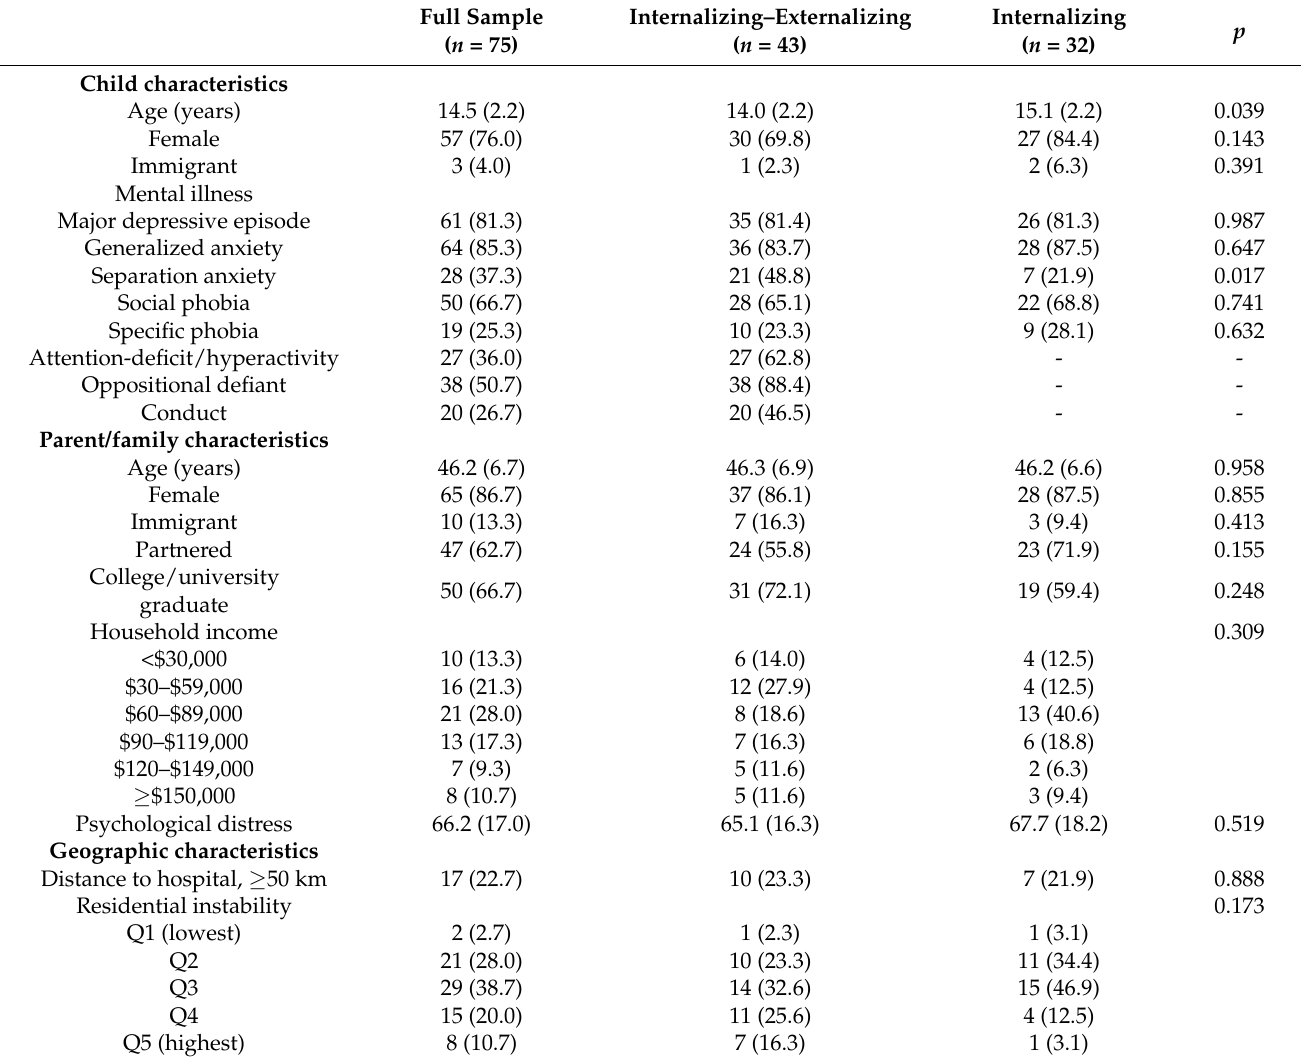
Table 1. Characteristics of the study